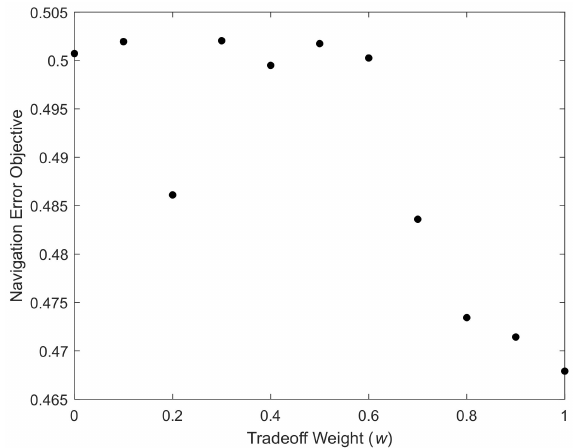
Figure 7. Navigation error objective vs. tradeoff weight.